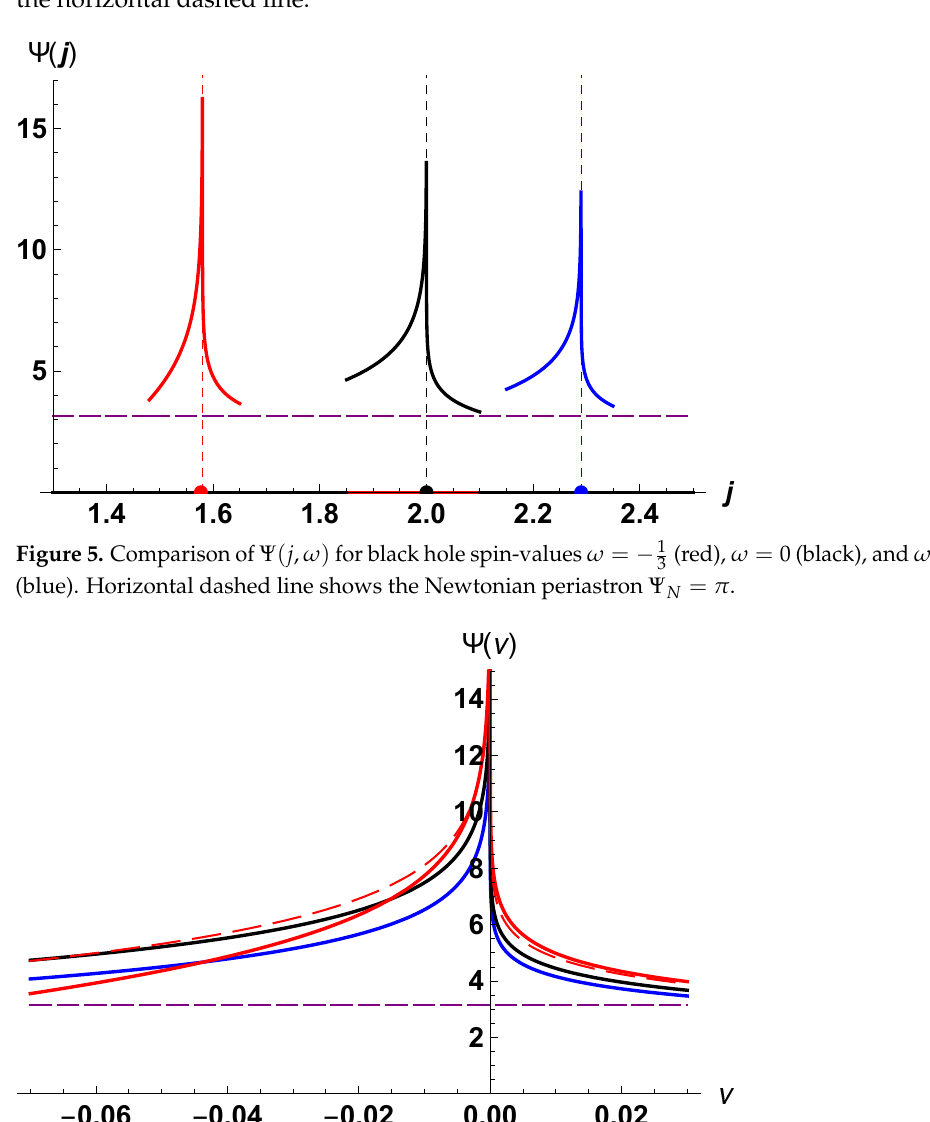
√ 1 + 2 ω , for black hole spin- (blue). Horizontal dashed 3